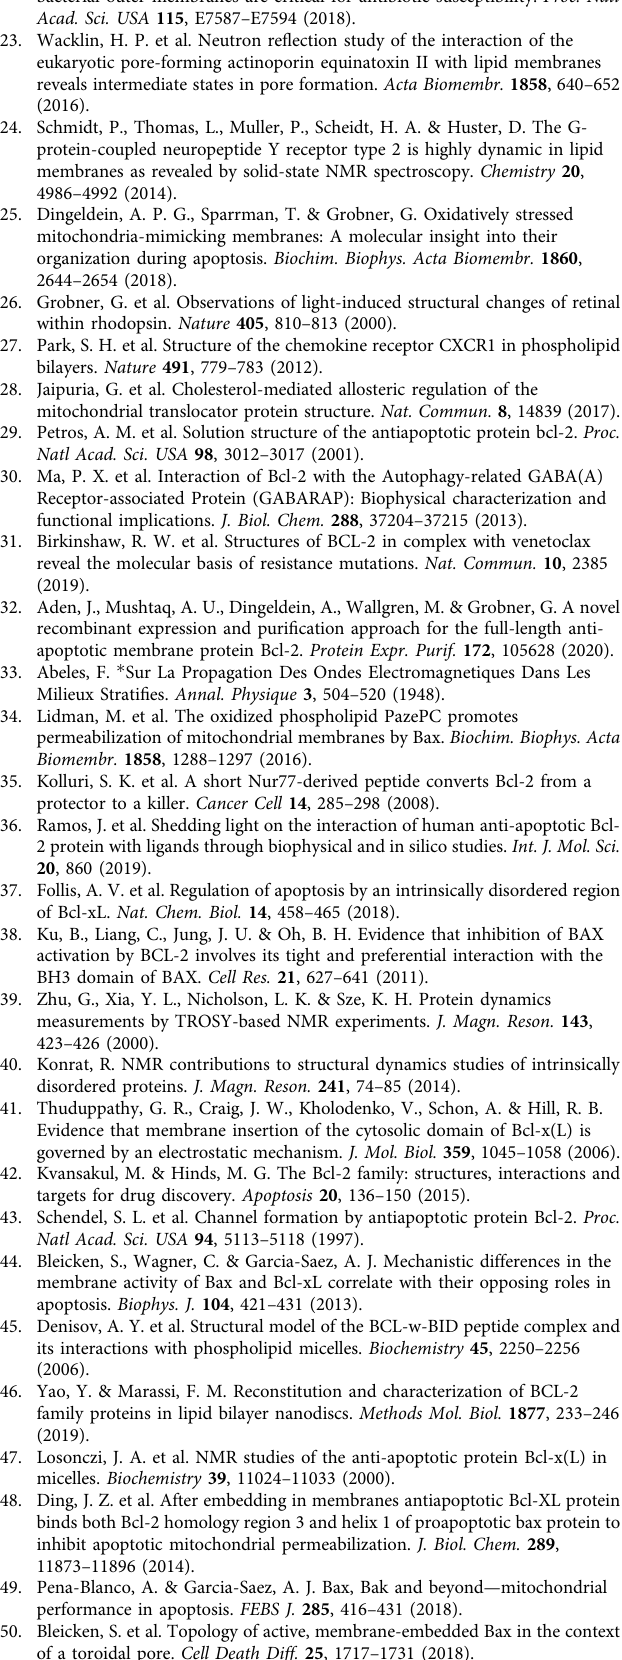
(Fig. 2) and once with h-Bcl-2:d-DMPC (Supplementary Fig. 2). Model parameter error estimation from the fi ts of these NR datasets was conducted using Rascals Bayesian Error estimation routines, with the log-likelihood function described in terms of chi-squared 22 . Marginalized posteriors were obtained using a Delayed Rejection Adaptive Metropolis algorithm 22 , and the best- fi t parameters taken as the distribution maxima; the uncertainties presented here are from the shortest 95% con fi dence intervals of each